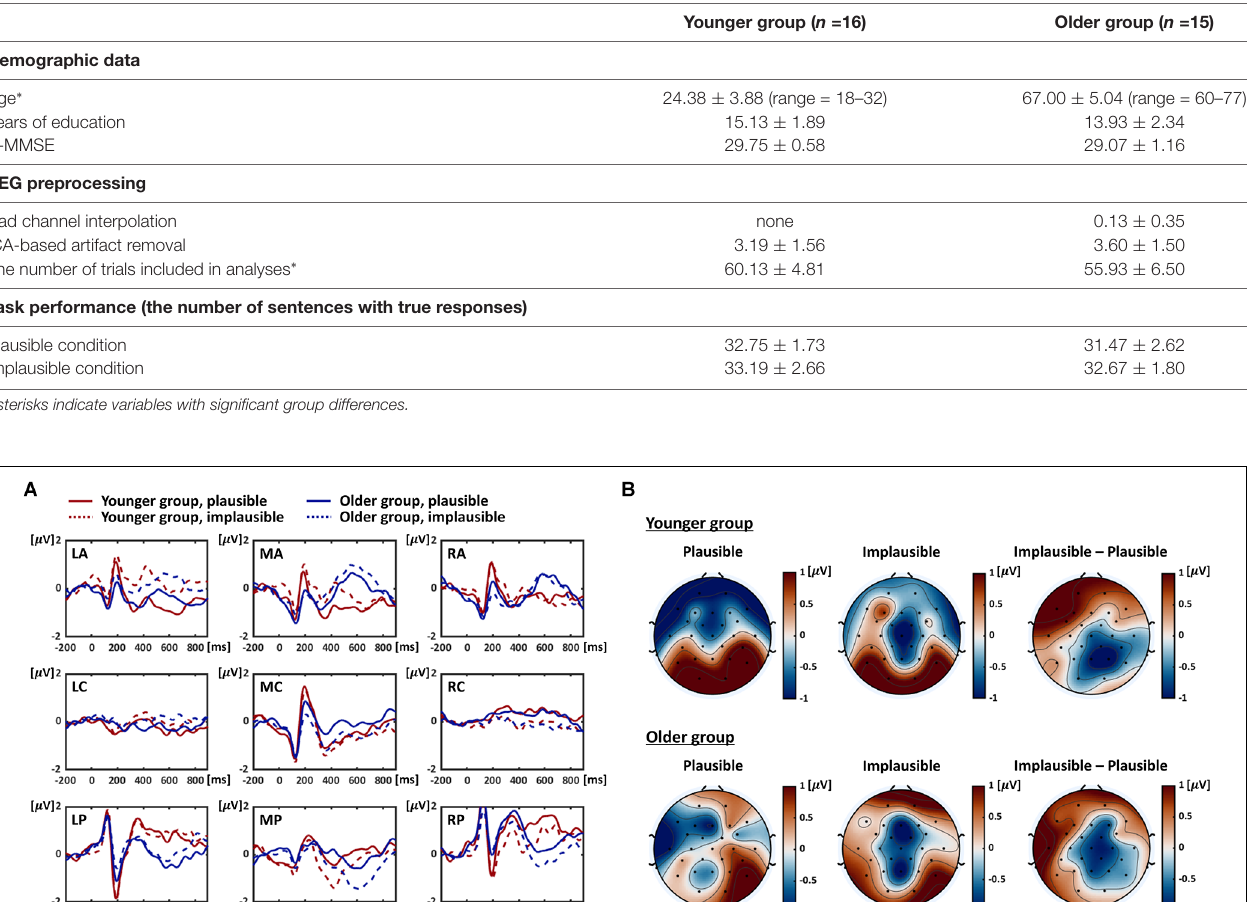
TABLE 2 | Characteristics of participants included in the final analyses.